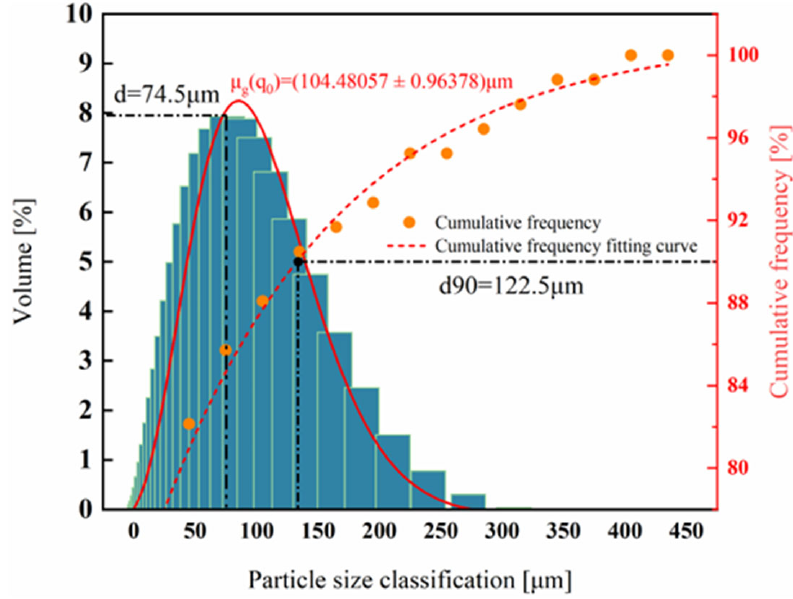
Figure 2. Particle size distribution of the SPUA modifier.